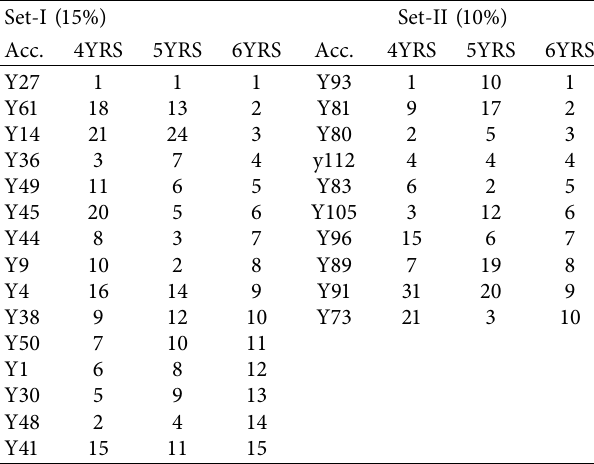
Table 6: Rank of the top 15 and 10 selected accession using over four, five and six years yield performance from original